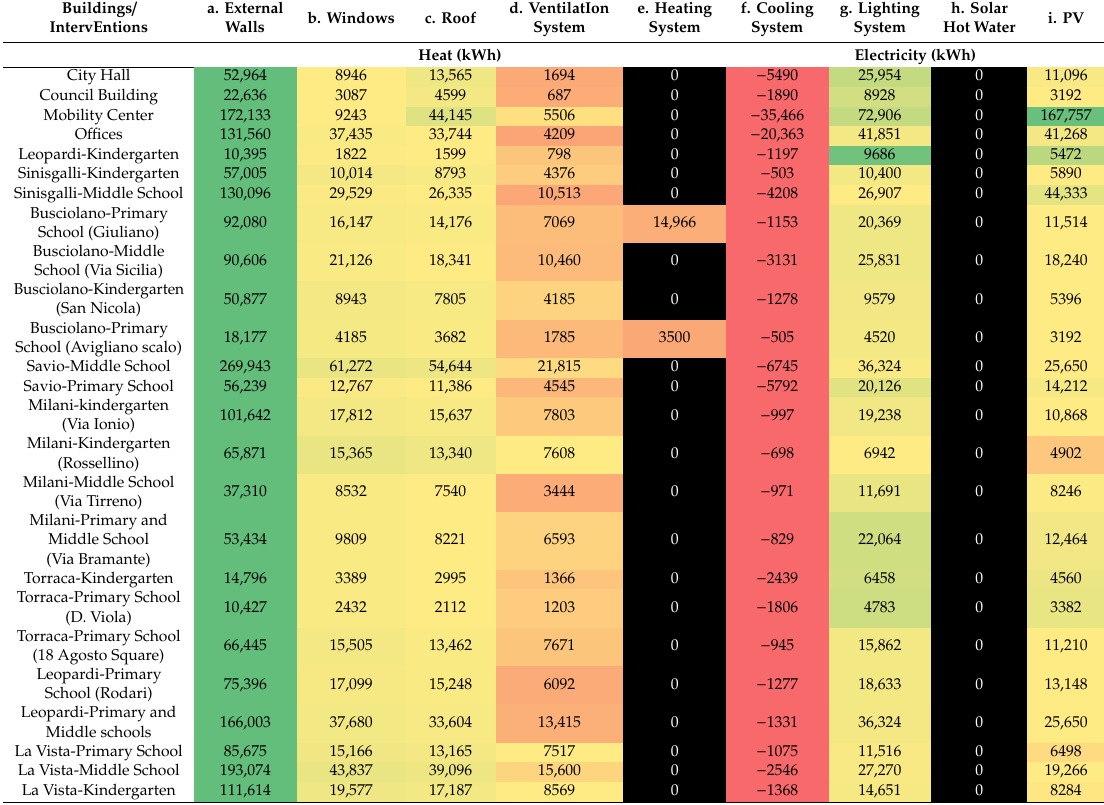
Table 2. Energy savings achievable with the implementation of energy e ffi ciency measures and renewable technologies for the selected Municipal Public Buildings (MPBs). The black background indicates measures that are not considered in the case